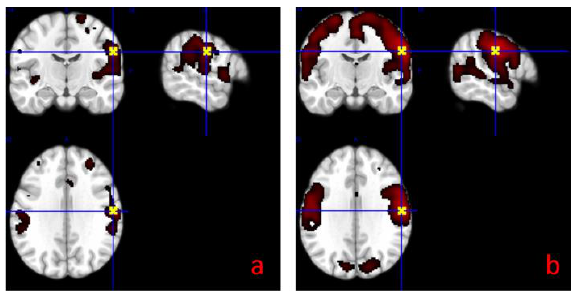
Fig. 6. Correlation maps of the brain with the selected seed (marked with the yellow x) for pre (a) and post (b) VR interaction, thresholded at r = 0.3 (z = 0.31).